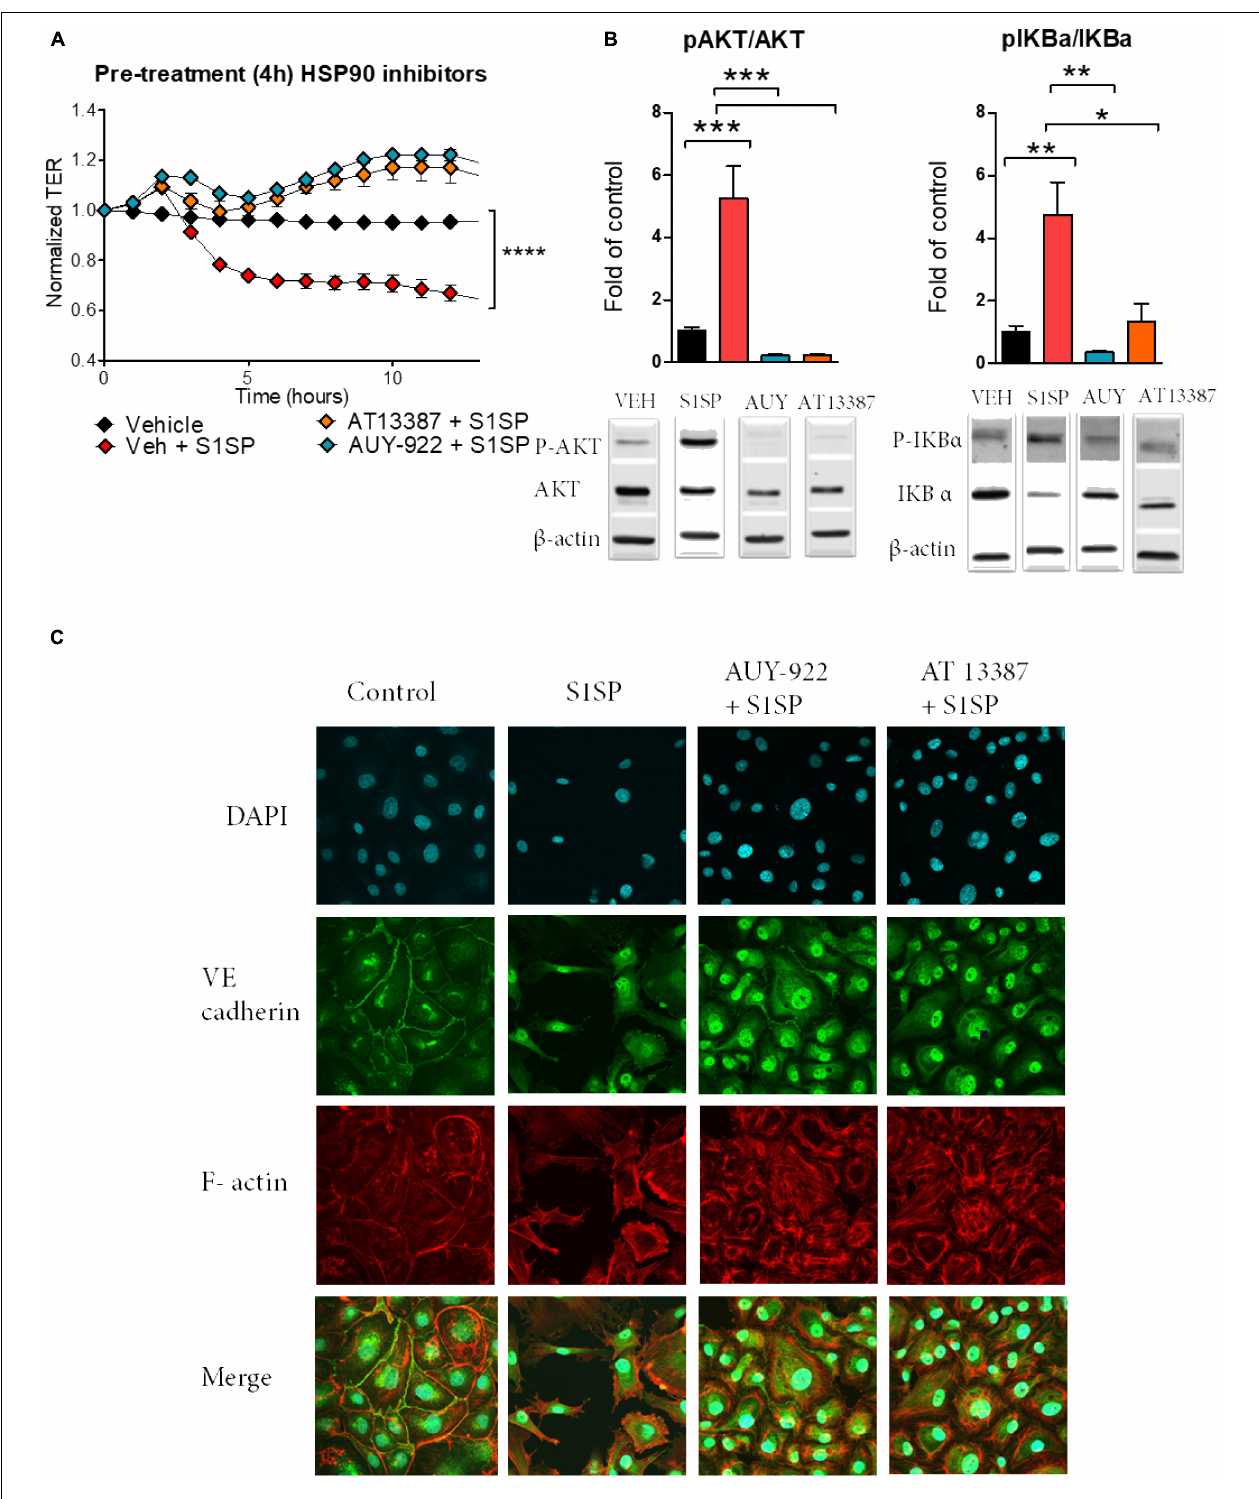
FIGURE 3 | Pretreatment with HSP90 inhibitors prevented S1SP-mediated endothelial dysfunction. (A) 4 h of pretreatment with either HSP90 inhibitor (2 µ M AUY-922 or AT13387), but not vehicle, prevented S1SP-mediated changes in transendothelial resistance. (B) Western blotting of activated (phosphorylated) and total AKT and IKB α from HLMVEC incubated for 4 h with HSP90 inhibitors before 4 h exposure to S1SP. (C) Immunostaining for VE-cadherin, F-actin, and DAPI of cells incubated 4 h with HSP90 inhibitors (2 µ M) and subsequently exposed for 4 h to 20 nM S1SP. Means ± SEM; n = 3–4; * p < 0.05; ** p < 0.01; *** p < 0.001 between groups, 1-way ANOVA and Tukey’s post hoc